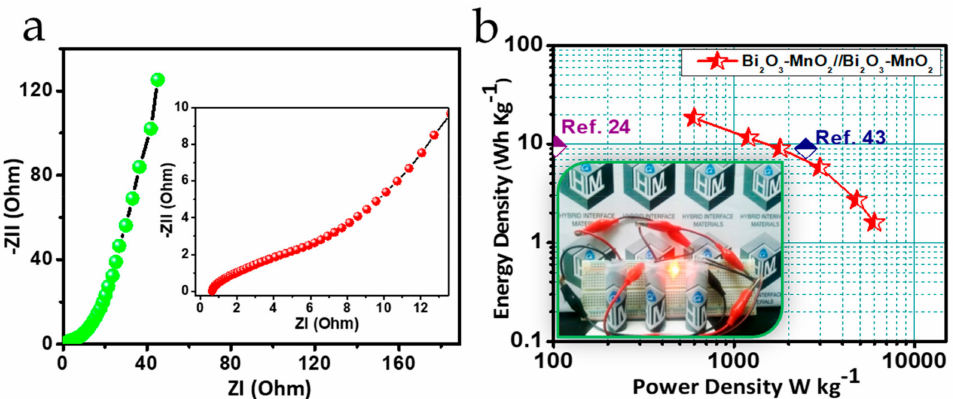
Figure 7. ( a ) Nyquist plot for Bi 2 O 3 -MnO 2 ES electrode (inset—magnified plot in the high frequency range) and ( b ) Ragone plot for the symmetric device assembly (inset—demonstrating LED lighting).